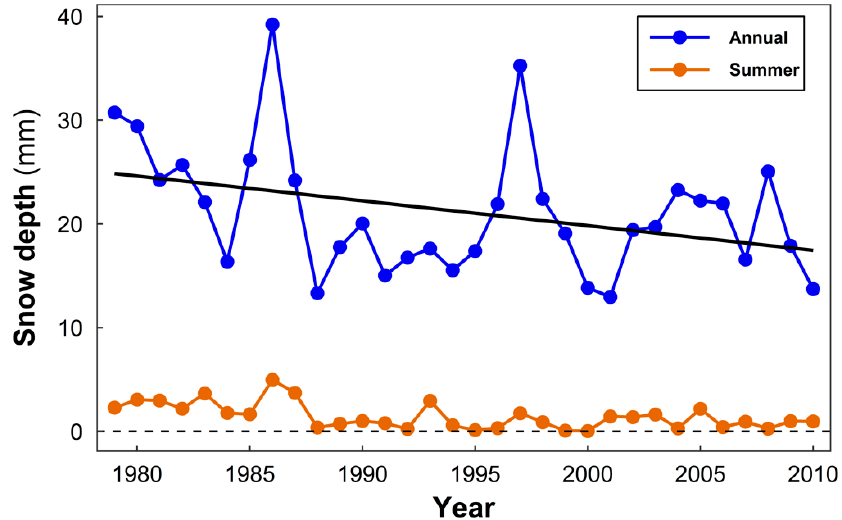
Figure 8. Catchment average snow depth of the whole year (blue line) and during the summer season (orange line). The solid black line is the linear trend of catchment average snow depth.